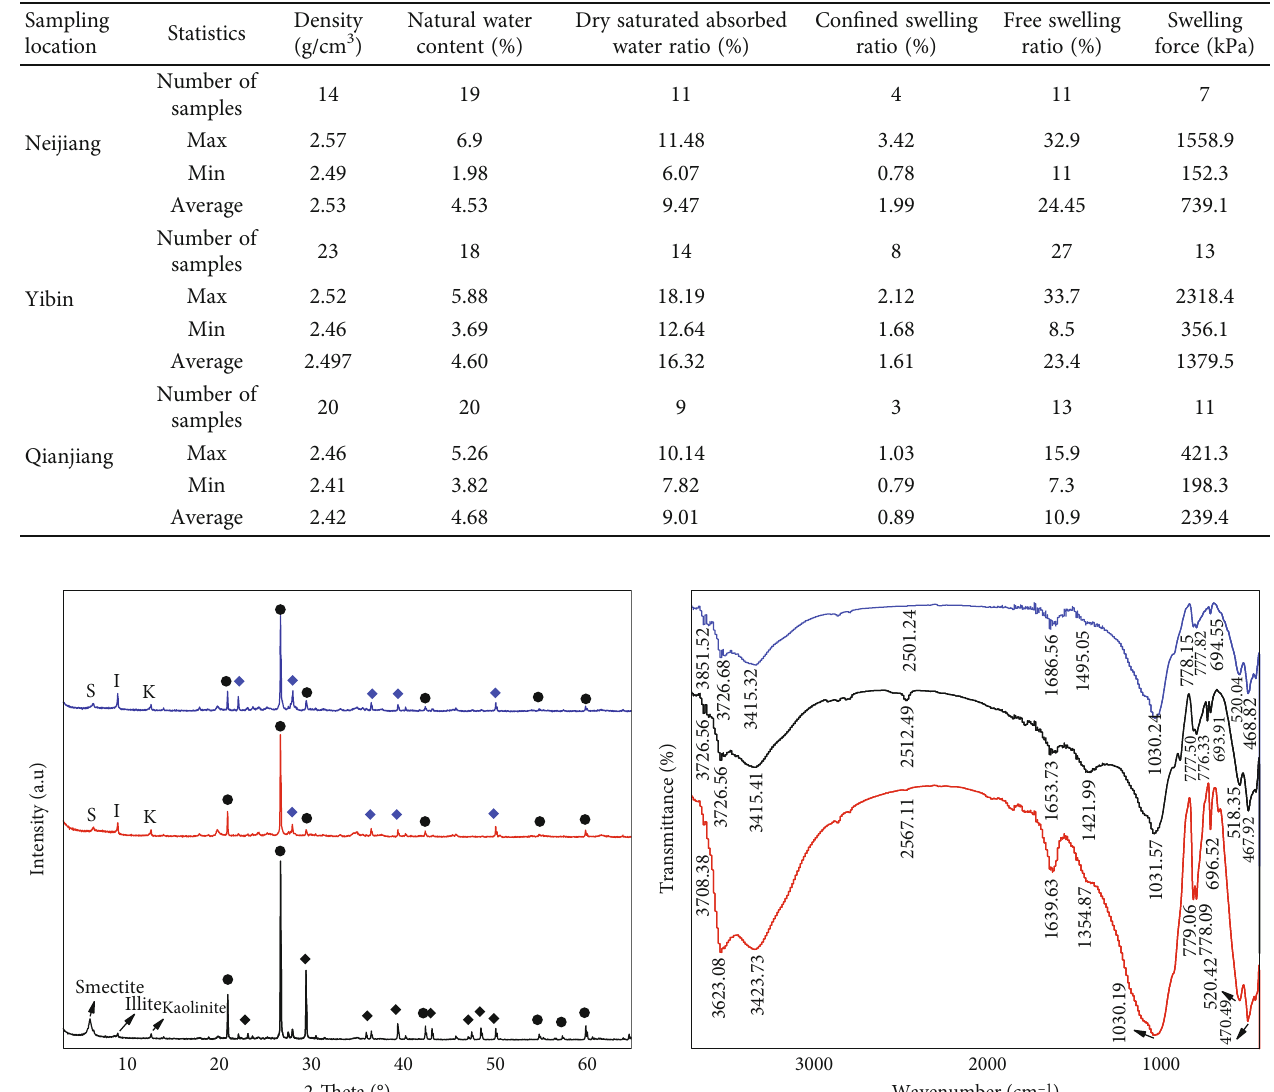
Table 1: Physical parameters of mudstone.